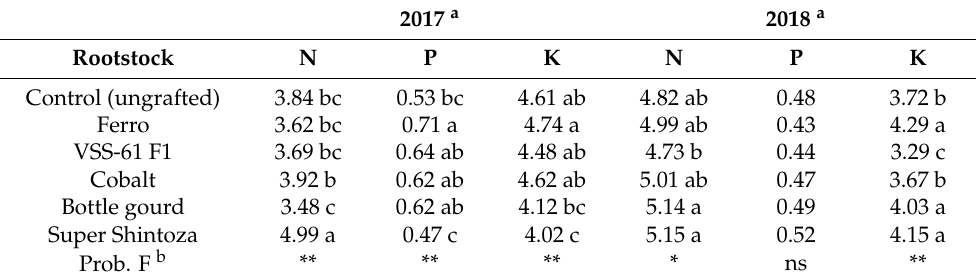
Table 6. Means of nitrogen (N), phosphorus (P), and potassium (K) contents in the leaves of Gianco F1 cucumber plants grafted onto five cucurbit rootstocks and the ungrafted control under heat and salinity stresses in the 2017 and 2018 seasons. Results are expressed as a percentage over dry weight. Details on the measurement of the traits presented are provided in the Material and Methods Section.